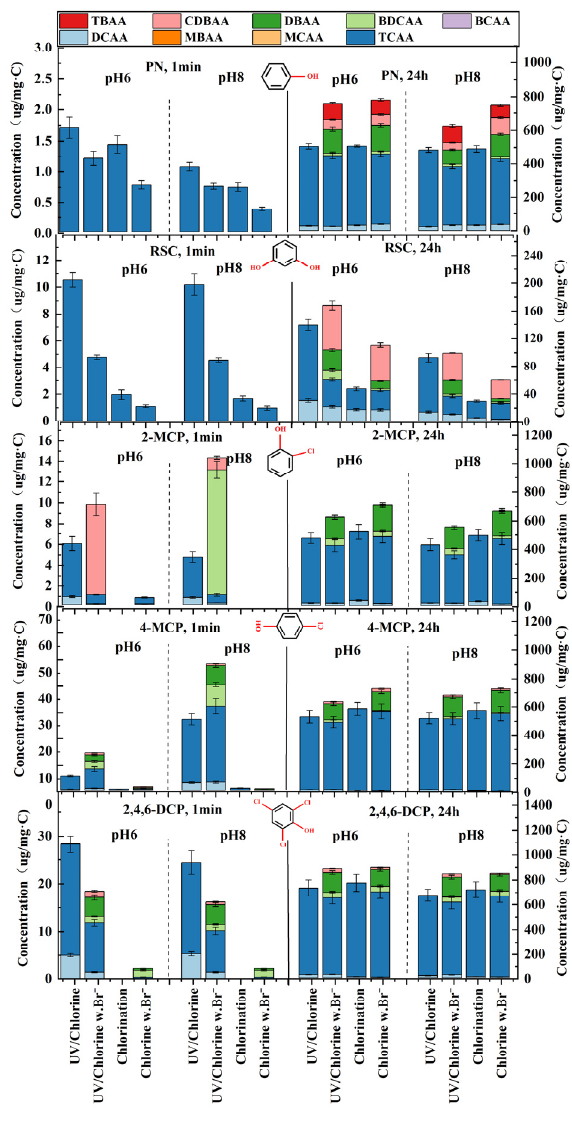
Figure 6. The formation of 4THM during the 1 min short-term oxidation and 24 h post-chlorination from five active benzene derivatives. Short-term oxidation conditions: Chlorine dose = 10 mg chlorine/L, pH = 6.0 or 8.0, [model benzene precursors] 0 = 3 mg-C/L, UV fluence rate = 10 mW/cm 2 , [bromide] 0 = 1 mg/L. Post-chlorination conditions: pH = 8.0, chlorination time = 24 h, chlorine residual = 1.0 ± 0.4 mg/L, dark, 22 °C.